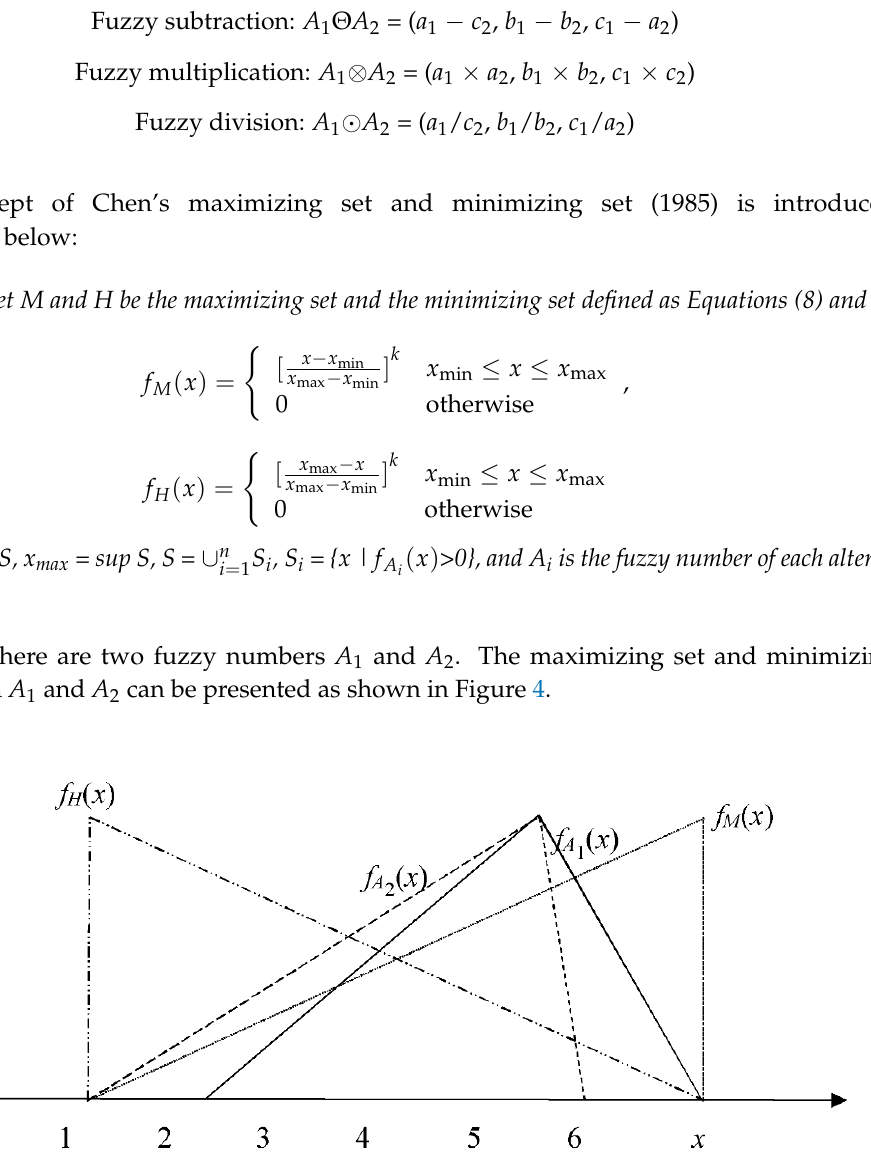
Figure 4. The maximizing set and minimizing set.